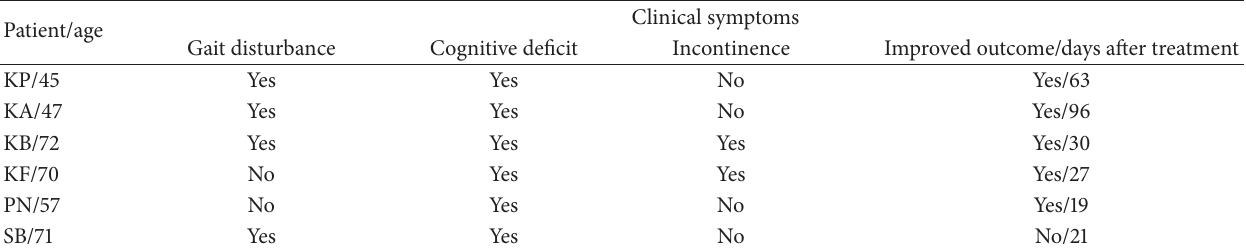
Table 1: Summary of six hydrocephalic patients including age, clinical symptoms before treatment with a ventriculoperitoneal shunt postoperative image performance and outcome evaluated in days after the